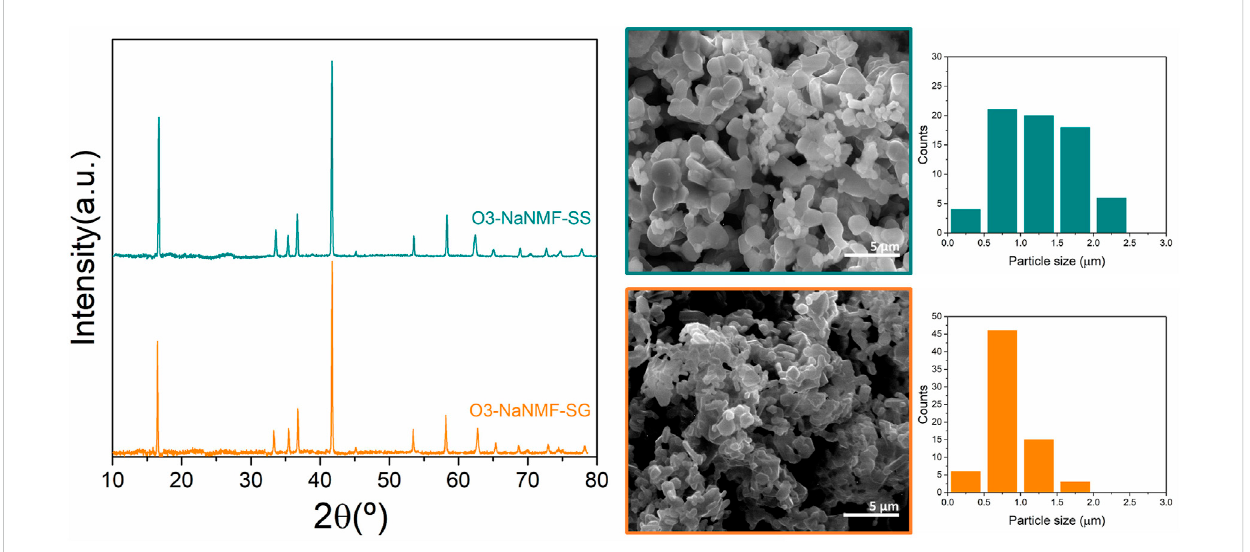
FIGURE 1 PXRD patterns and SEM images of O3-NaNMF synthesized via solid-sate (O3-NaMF-SS) and sol-gel (O3-NaMF-SG) routes.